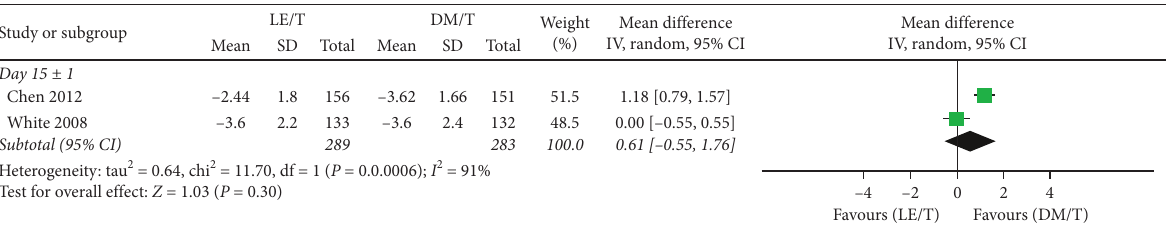
Figure 7: Forest plot of CFB in conjunctivitis signs composite score at day 15 ± 1.